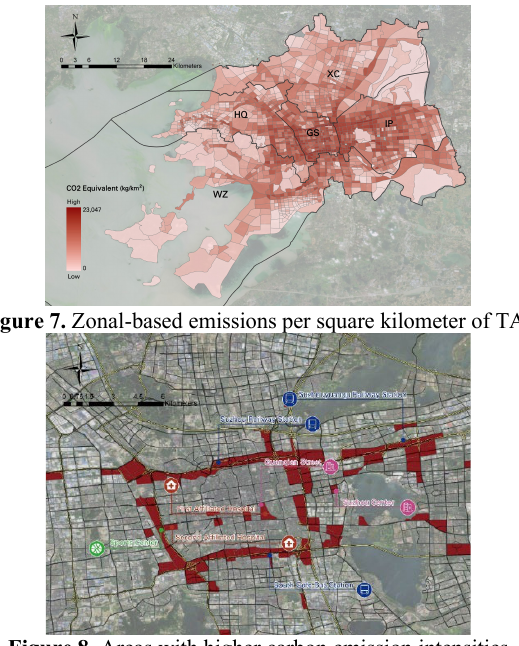
Figure 8. Areas with higher carbon emission